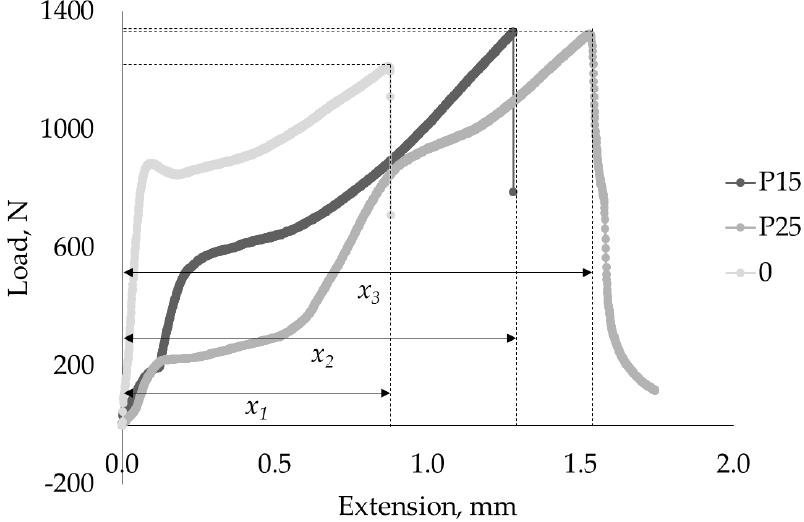
Figure 9. Load-extension curve for solder joints with and without porous Cu soldered at 307 °C with soldering time of 300 s.